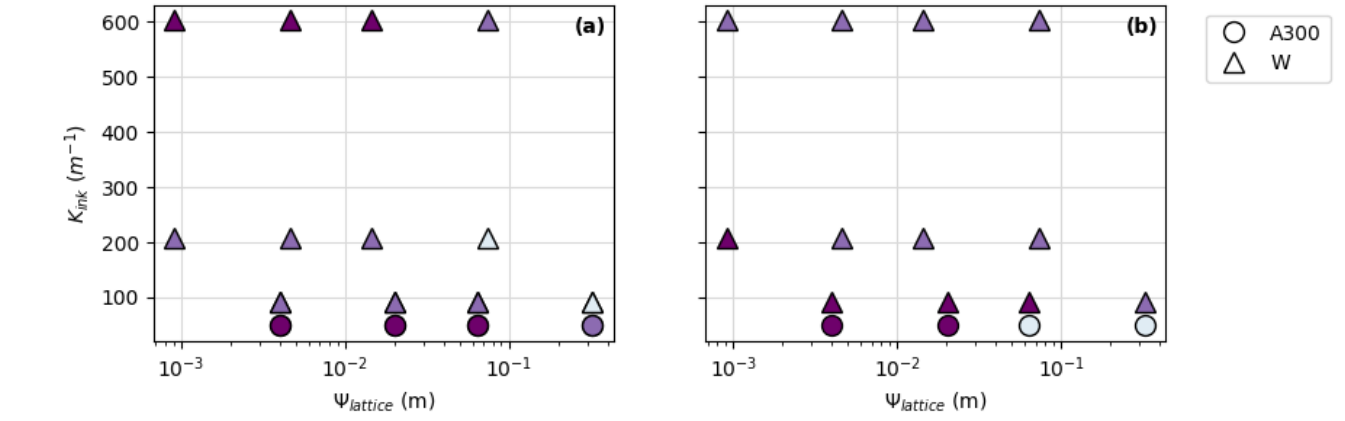
Figure 10. Subset of data points from Figure 9 showing ink rheology (K ink ) vs. lattice parameter ( Ψ lattice ) for A300 and tungsten-filled: ( a ) FCT prints and ( b ) SC prints. The darkest symbols represent pads with <10% thickness deviation; the second-darkest symbols represent pads with <20% thickness deviation; and the lightest symbols represent pads with >20% thickness deviation.